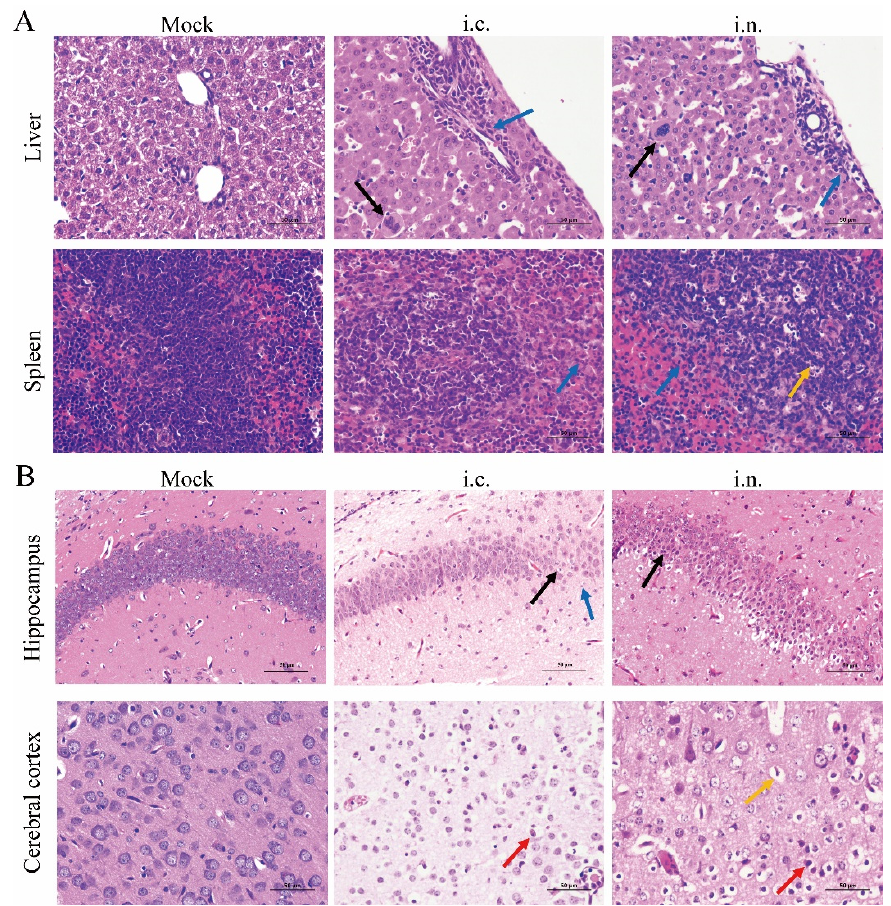
Figure 3. DENV-2 infection results in pathological changes. ( A ) Selected organs were harvested from intracranially or intranasally challenged mice sacrificed in a late phase of illness (5 and 9 dpi, respectively) and stained with hematoxylin and eosin (H & E). Blue arrows, granulocytes; black arrows, multinucleated giant cells; yellow arrows, apoptotic bodies. ( B ) Brains were harvested from intracranially or intranasally challenged mice sacrificed in the late phases of illness (5 and 9 dpi, respectively) and stained with H & E. Blue arrows, gliocyte proliferation; black arrows, necrotic pyramidal cells; red arrows, necrotic neurons; yellow arrows, cytoplasmic vacuoles. Scale bar: 50 µ m. Abbreviations: i.c., intracranial; i.n.,